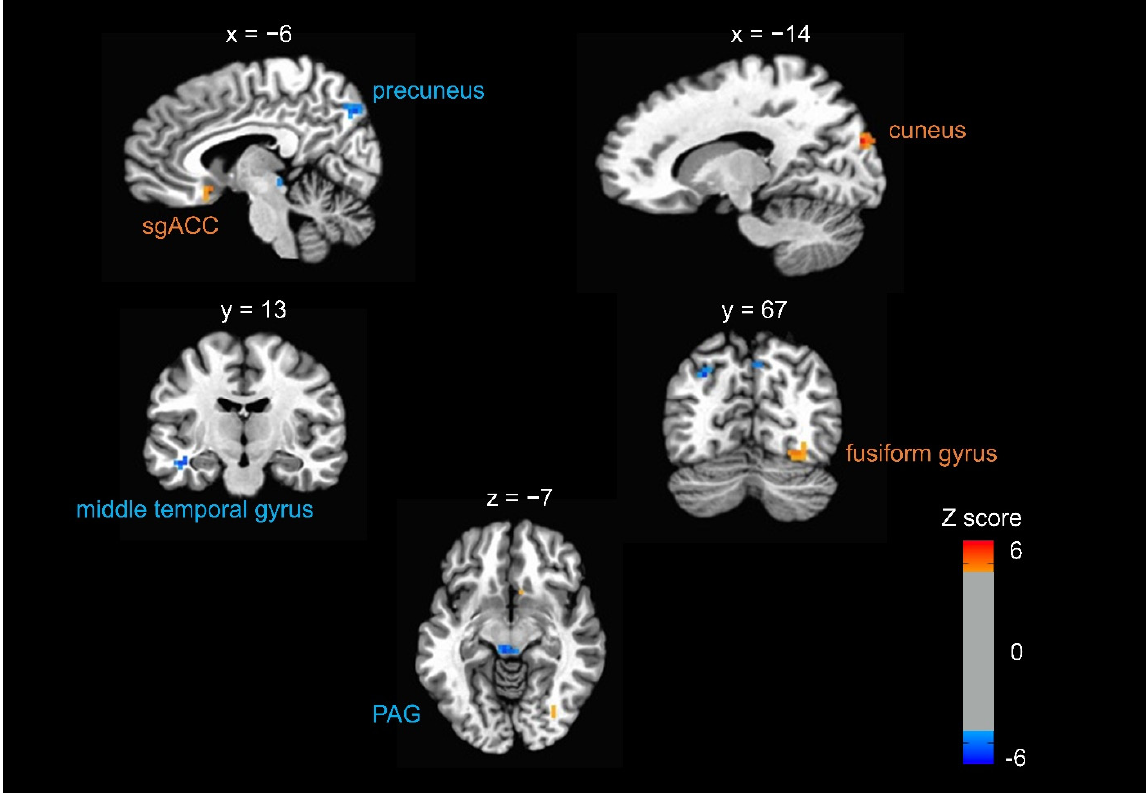
Figure 3. Brain responses to fearful faces in the CV17 versus control condition . The contrast between the CV17 condition and the control condition revealed that the brain activity elicited by viewing fearful faces changed under the condition of expecting somatosensory stimulation of the chest. When the participants viewed fearful faces in the CV17 condition, we observed significantly increased brain activity in the right cuneus, fusiform gyrus, and subgenual anterior cingulate cortex (sgACC), and significantly decreased brain activity in the bilateral periaqueductal gray (PAG) and precuneus and left middle temporal gyrus (MTG) ( p < 0.05, FWE corrected) compared to the control condition. Table 1. Brain response to fearful faces when expecting somatosensory stimulation of the chest (CV17) compared to the control condition.